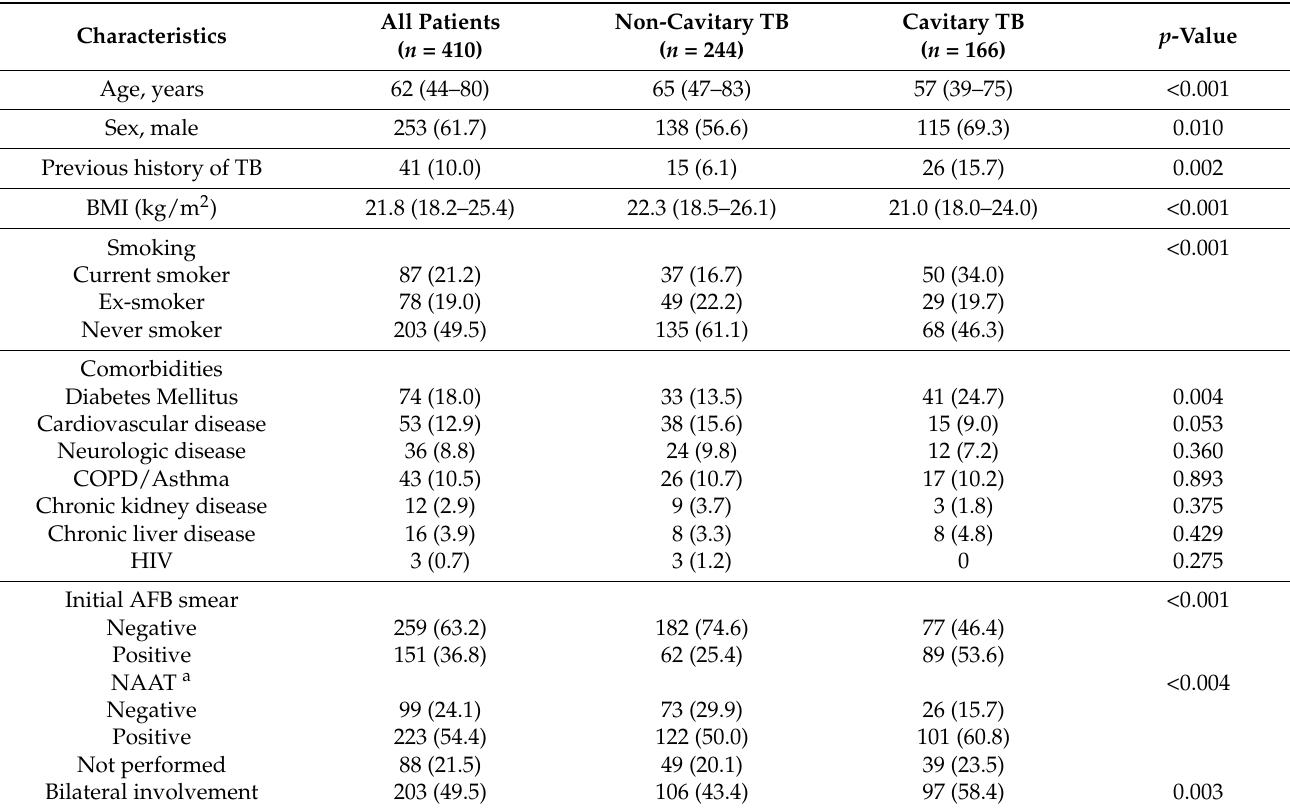
Table 1. Baseline characteristics of study